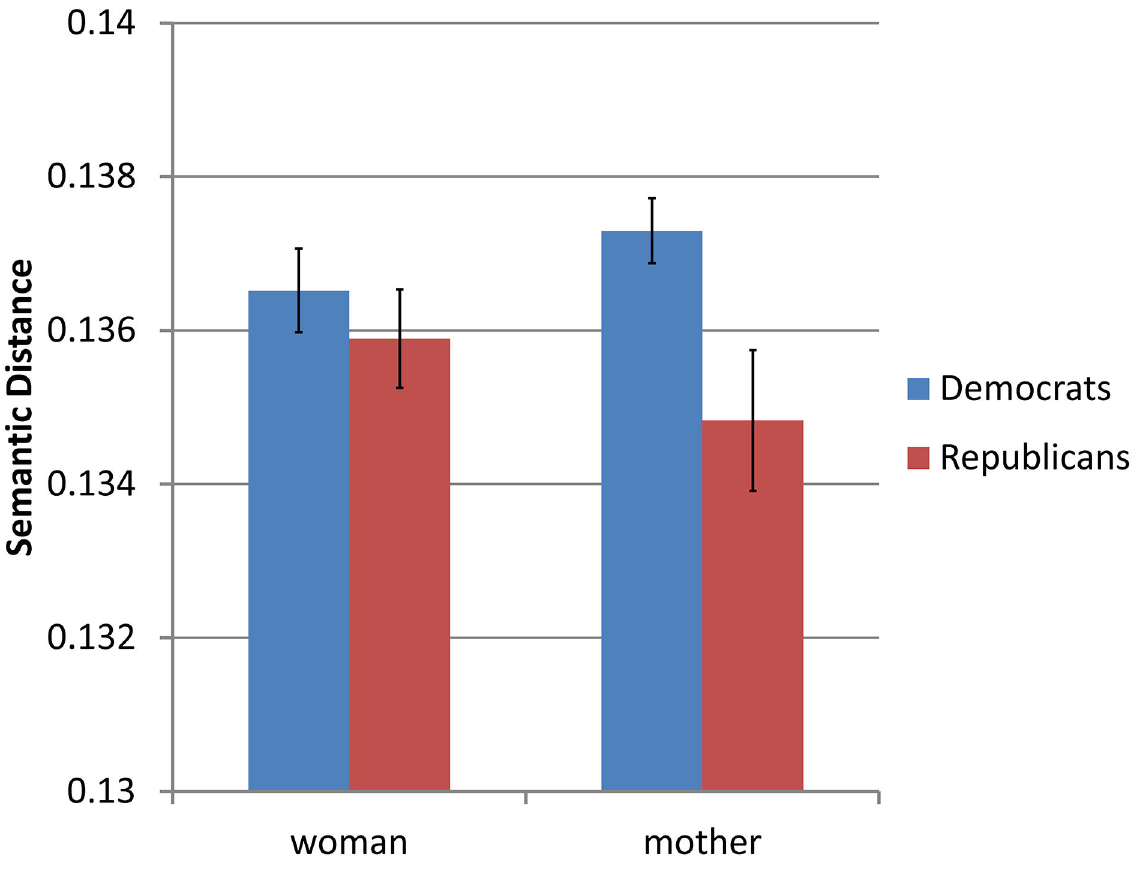
Figure 6. Mean context vector distances of mother and woman from abortion by the speaker’s party affiliation. As the zero point of the graph represents identical uses for the term in question and abortion, lower positions in the graph represent greater relevance for the term as a frame of abortion . Error bars represent standard